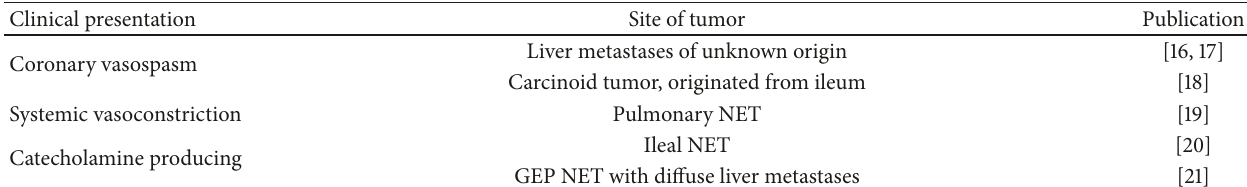
Table 2: Similar case reports in